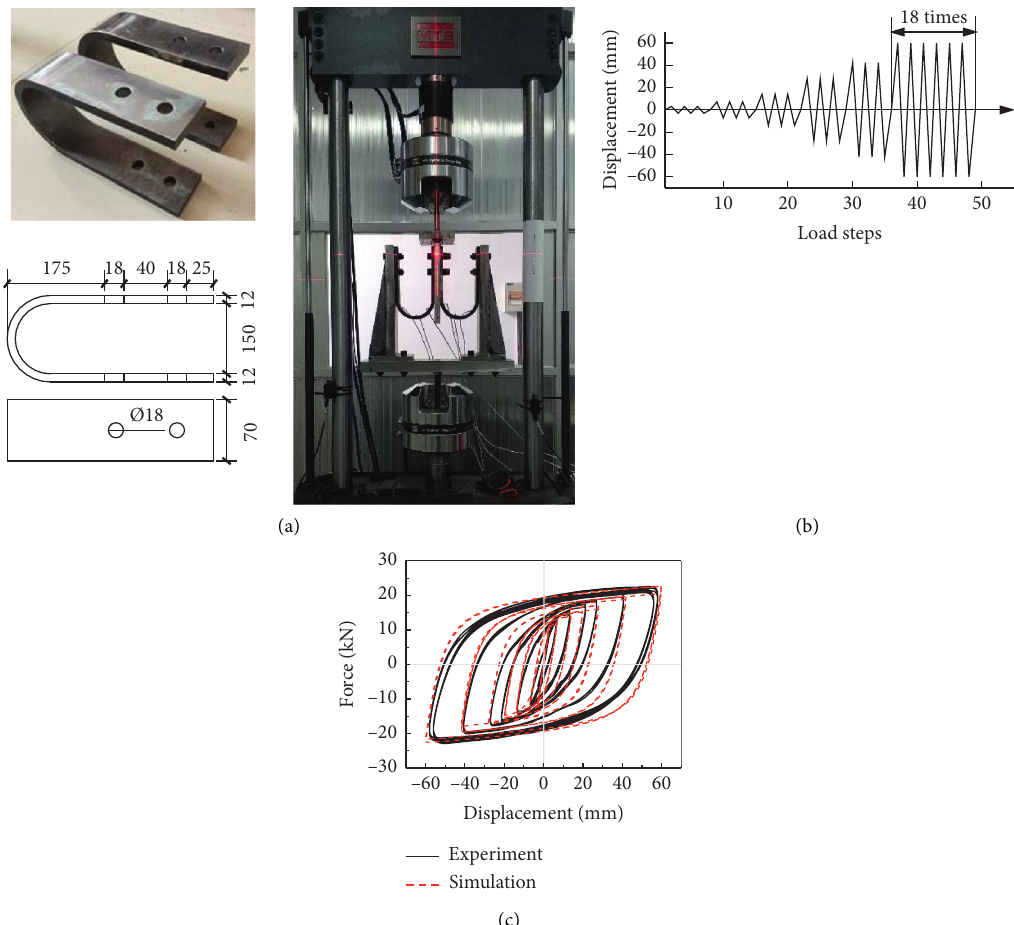
Figure 3: Calibration of the USD finite element model. (a) Loading device and the design of the USD (unit: mm). (b) Loading protocolin the test. (c) Comparison of the simulations and